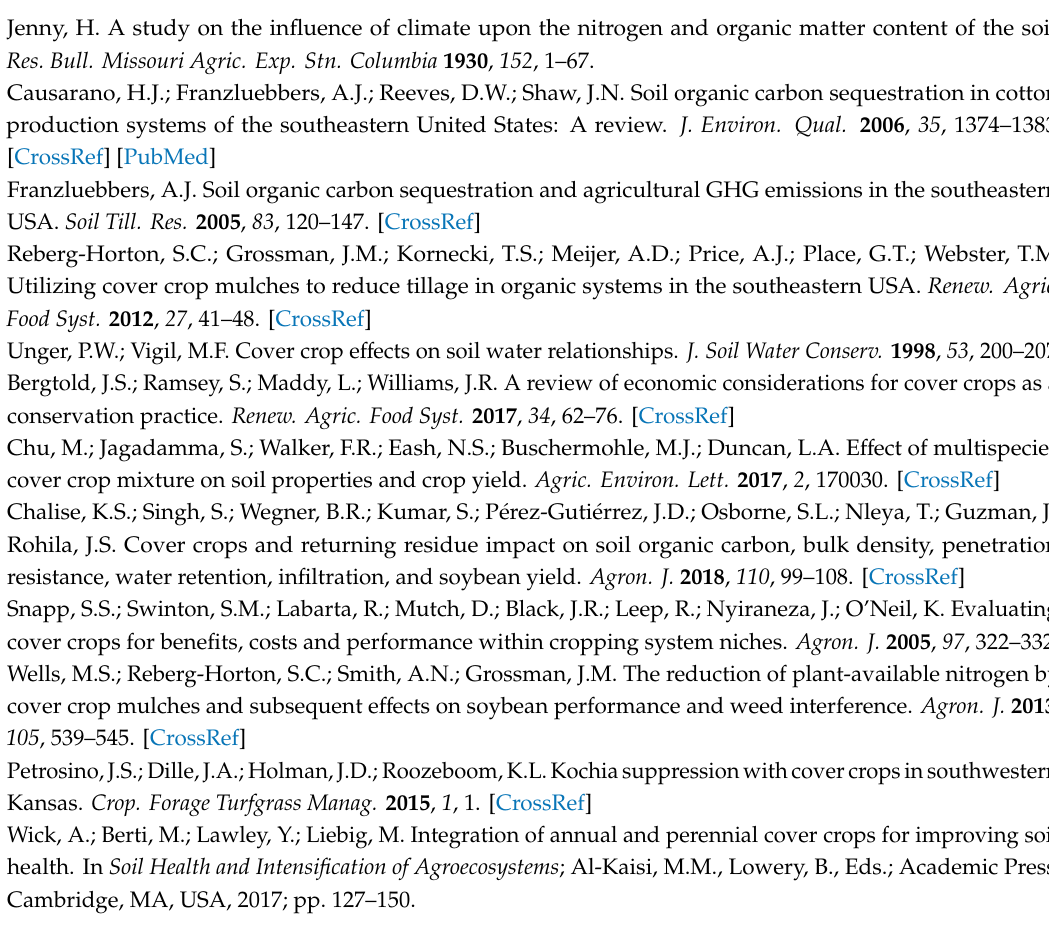
Table S1: Data collected on cover crop biomass production on various measurement dates in season-1 (2016–2017) and season-2 (2018). Table S2: Data collected on volumetric soil water content at 10, 20, 30, 40, and 60 cm depths under each of the seven cover crop treatments and two control treatments (Fallow with herbicide application (control-1) and fallow without herbicide application (control-2)) on multiple measurement dates during